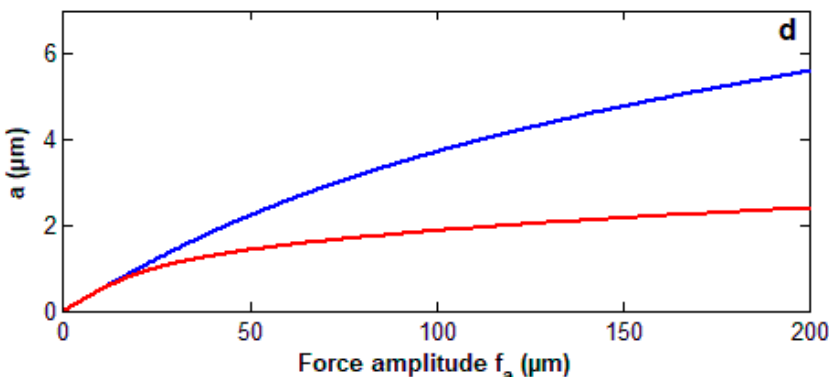
Figure 6. ( a ) The curve of force response for the system before and after control at σ 1 = 0. ( b ) The curve of force response for the system before and after control at σ 1 = 2. ( c ) The curve of force response for the system before and after control at σ 1 = 5. ( d ) The curve of force response for the system before and after control at σ 1 = − 5.